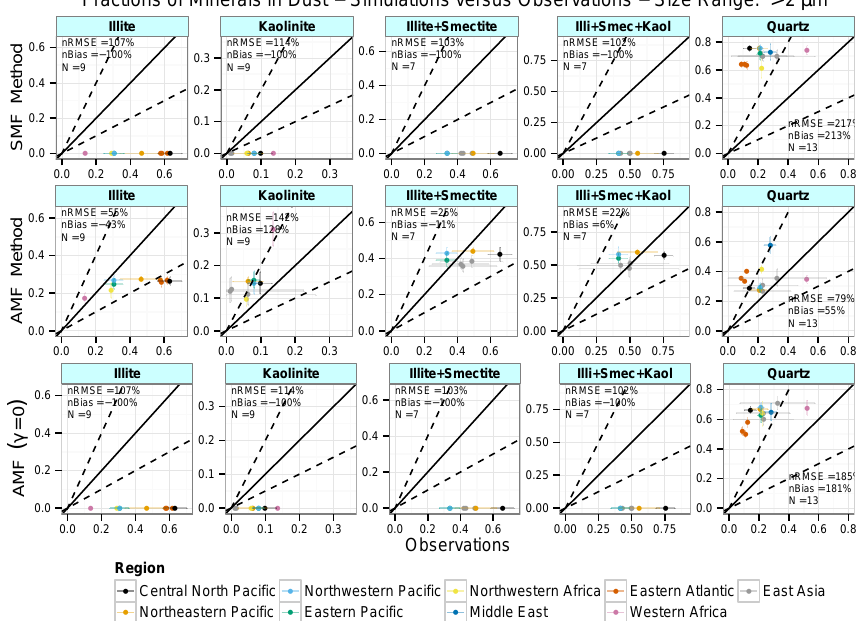
Figure 4. Scatterplot of mineral fractions of illite, kaolinite, the sum of illite and smectite, all phyllosilicates and quartz for silt particles (whose diameters are greater than 2µm) simulated by the SMF, AMF and AMF ( γ = 0) experiments vs. measurements. The dashed lines mark ratios of 2 : 1 and 1 : 2 between the simulated and observed mineral fractions. The horizontal and vertical error bars show the 95% confidence interval.